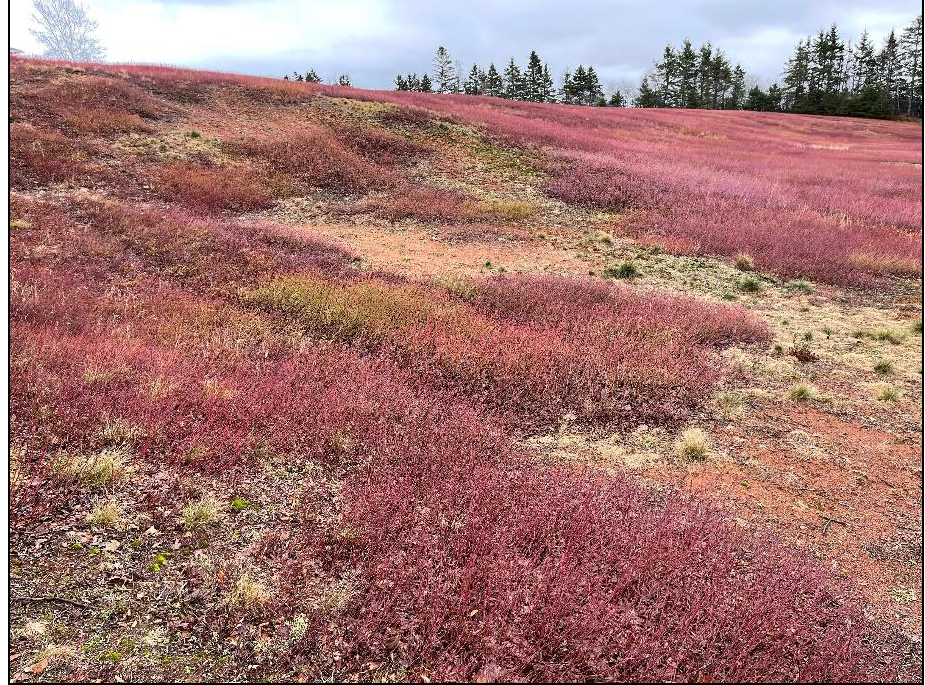
Figure 3. Image of Site 1 showing rough natural terrain common to Nova Scotian wild blueberry fields. In order to quantify slope in field, 20 randomly selected points were assessed within each of the fields. Slopes were referenced as their absolute slopes and measured in de- grees. Minimum, maximum, and average slopes for each of the fields can be observed in Table 2.